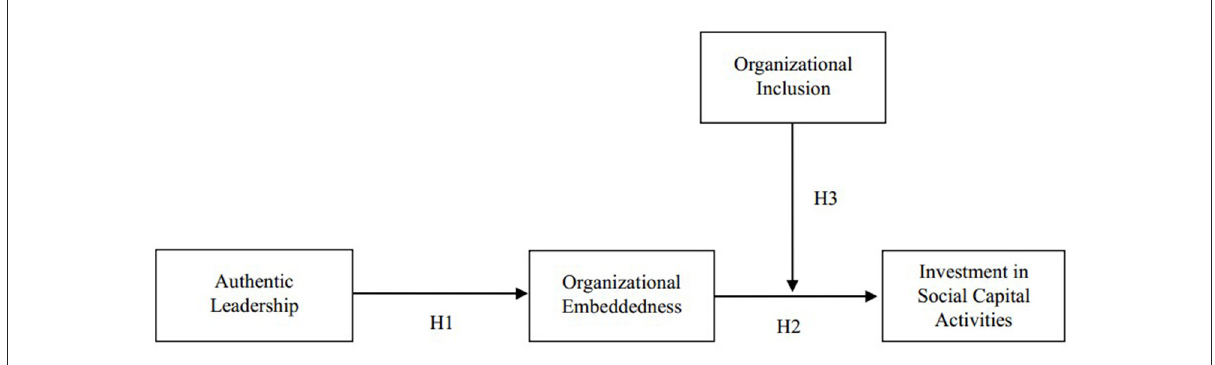
FIGURE1 Research model of this